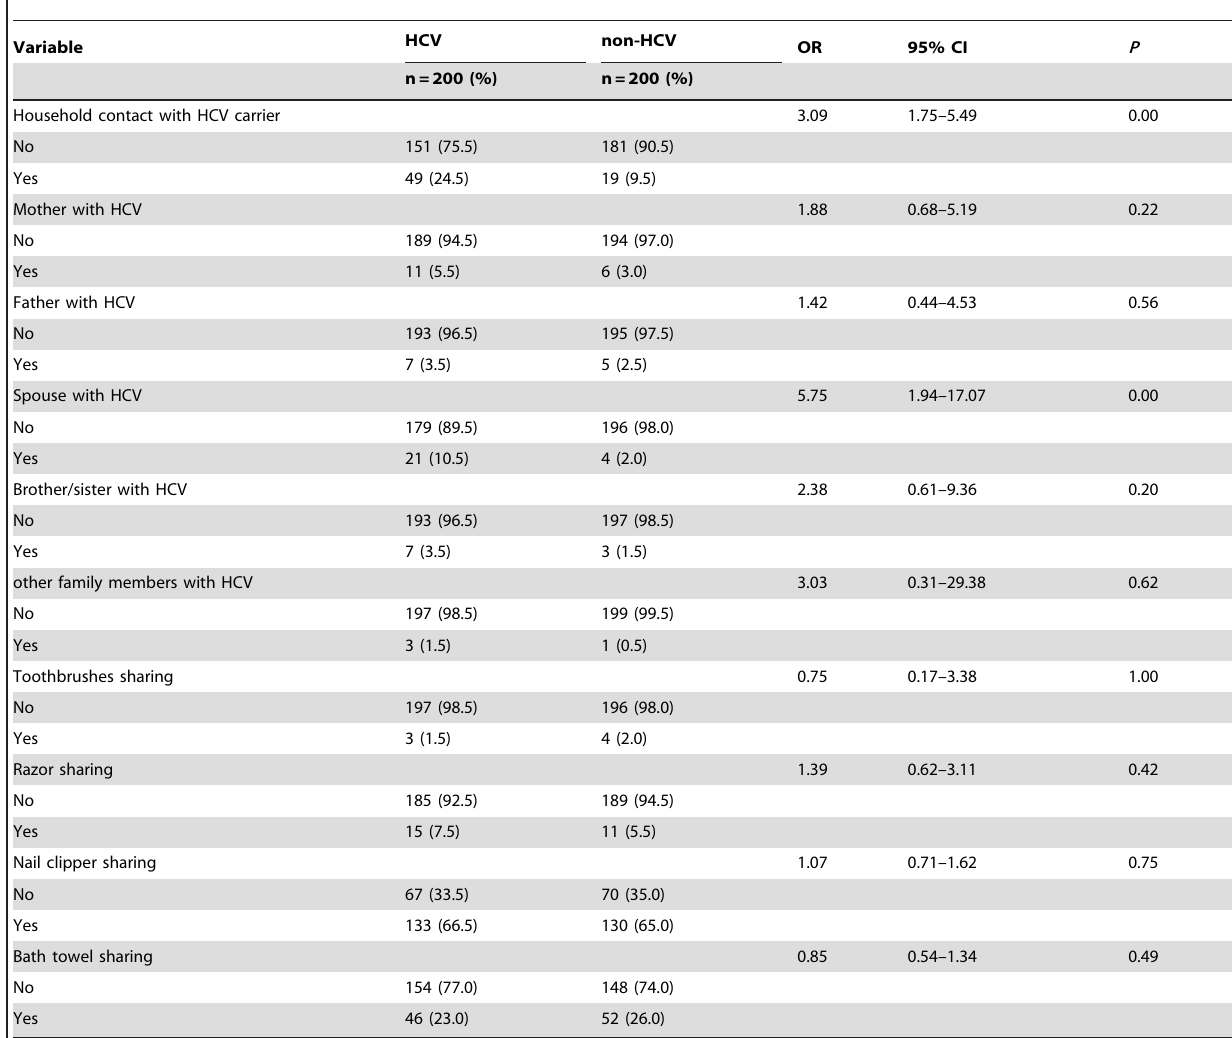
Table 3. Risk factors related to daily life behaviour among HCV and non-HCV